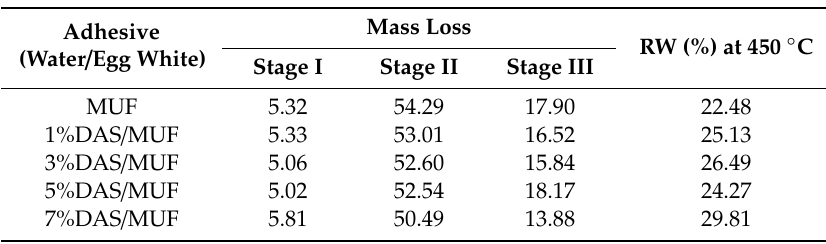
Table 3. The mass loss (%) of di ff erent adhesive samples in three degradation stages and the residual weight (RW) at 450 ◦ C.